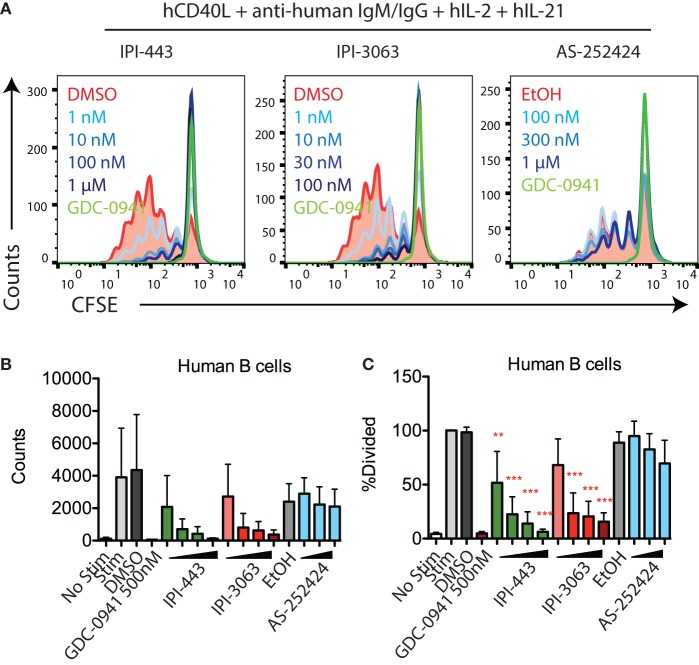
IPI-3063 potently inhibits human B cell proliferation. (A–C) Purified human B cells were pretreated with inhibitors for 30 min, then stimulated with human CD40L + anti-human IgM/IgG + human IL-2 + human IL-21 for 120 h. Concentrations used were 1 nM, 10 nM, 100 nM, and 1 µM for IPI-443, and 0.1, 1, 10, and 100 nM for IPI-3063. AS252424 concentrations were 100 nM, 300 nM, and 1 µM, and GDC-0941 was at 500 nM. Total numbers and percent divided were determined by the number of CD19+7AAD−CFSElo cells. Samples were collected by time (*P < 0.05, **P < 0.001, ***P < 0.0001 one-way ANOVA with Newman–Keuls multiple comparison test).